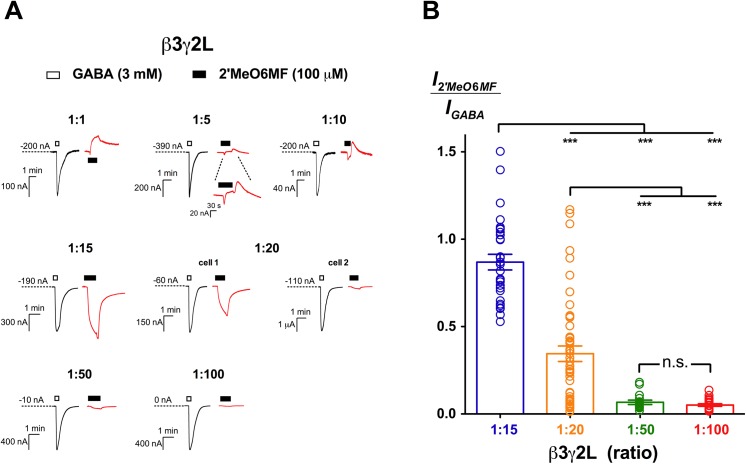
2’MeO6MF activity at β3γ2L GABAARs.(A) 2’MeO6MF exhibits a complex spectrum of activity across β3γ2L GABAARs expressed at various injection ratios. Representative traces of 3 mM GABA (black) and 100 μM 2’MeO6MF (red) are shown for each ratio. Bars indicate durations of drug application. The holding current values are represented by the dotted lines. (1:1; n = 7), 2’MeO6MF inhibited the constitutive activity of receptors expressed. (1:5; n = 5) and (1:10; n = 10), 2’MeO6MF exhibited mixed agonist and inverse agonist activity. (1:15; n = 30), 2’MeO6MF directly activated receptors expressed efficaciously. (1:20; n = 49), 2’MeO6MF activated β3γ2L (1:20) receptors with variable efficacy. Sample traces of cell 1 and 2 were taken from a simultaneous experiment conducted on two different oocytes injected at the same time. (1:50; n = 15) and (1:100; n = 21), 2’MeO6MF showed activation with low efficacy at these receptors. (B) Mean efficacy of 100 μM 2’MeO6MF direct activation at β3γ2L (1:15), (1:20), (1:50) and (1:100) GABAARs. Data are normalised to the 3 mM GABA response. The mean efficacy of 100 μM 2’MeO6MF at various ratios was compared using Tukey’s test, and the significance levels are indicated with n.s. (not significant) and *** (p ≤ 0.001).